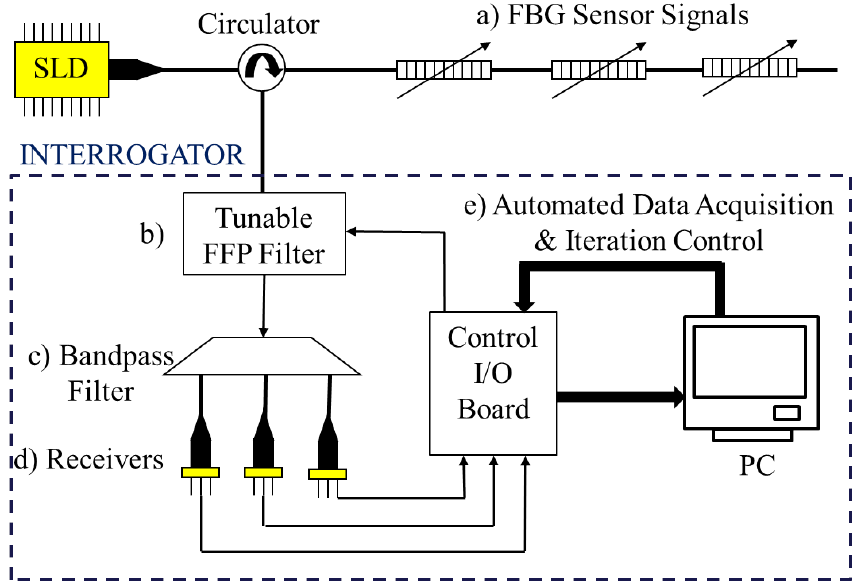
Figure 4. FBG Network architecture showing prnciple operation of interrogator. Reproduced with permission from [118], Copyright IEEE Photonics Technology Letters,